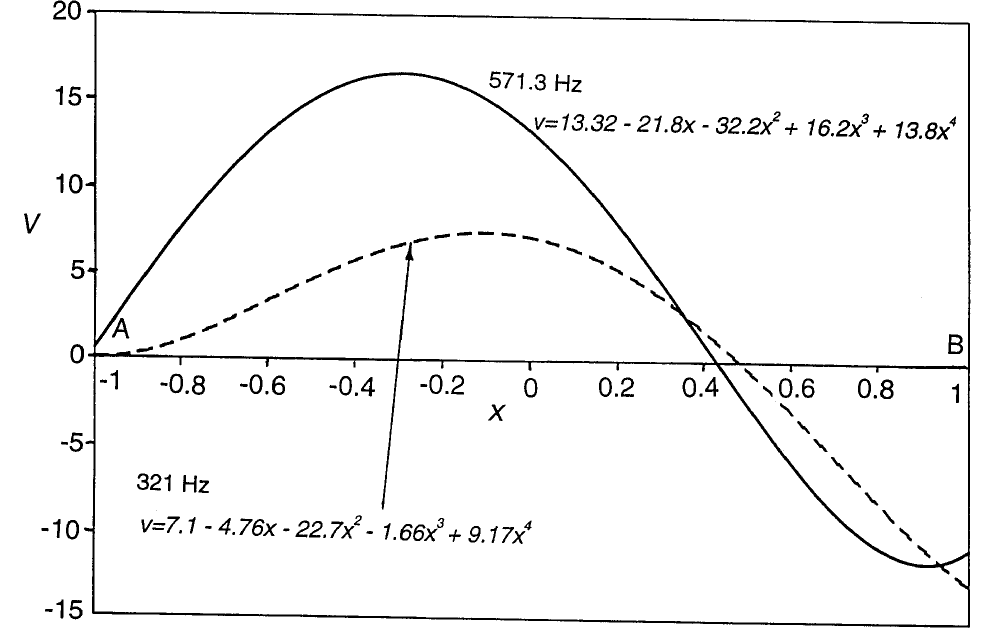
Fig. 7. Plate mode shapes, measured on scan line